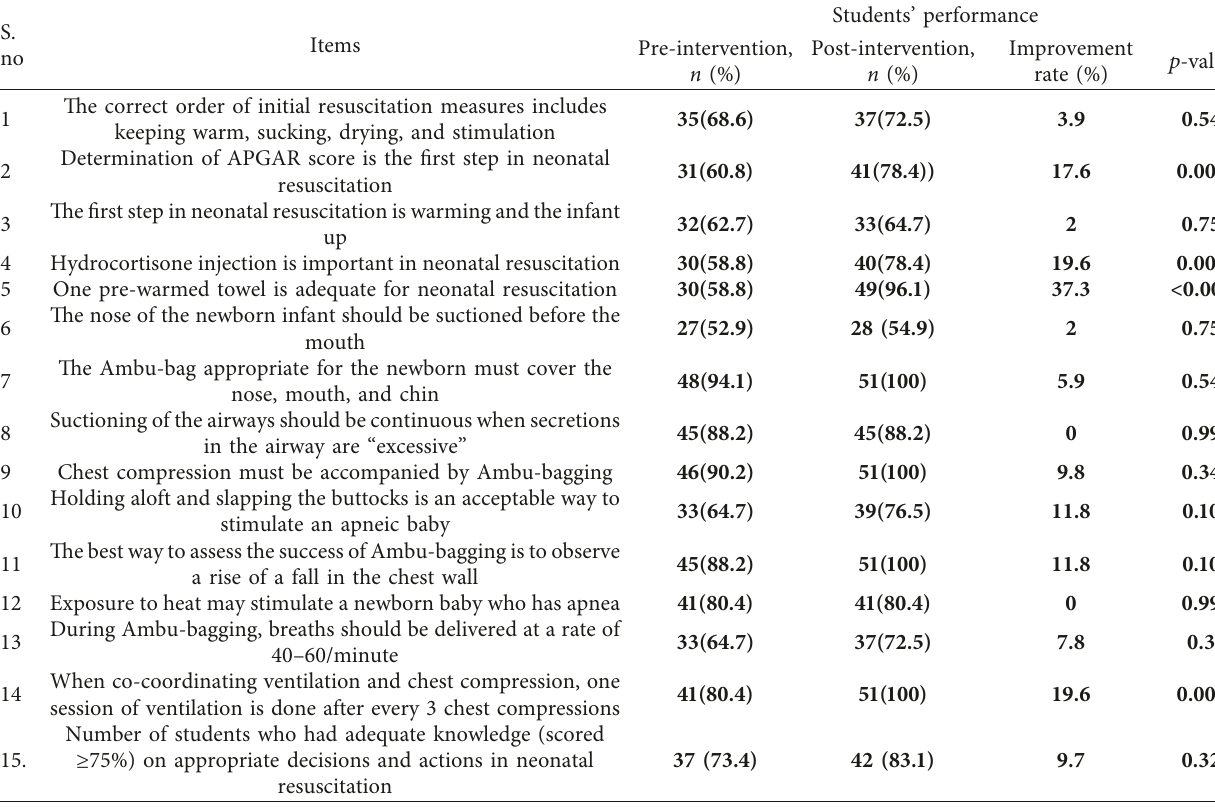
Table 5: Comparison of pre-intervention and post-intervention knowledge of appropriate decisions and actions for neonatal resuscitation of undergraduate final-year anesthesia students ( N �